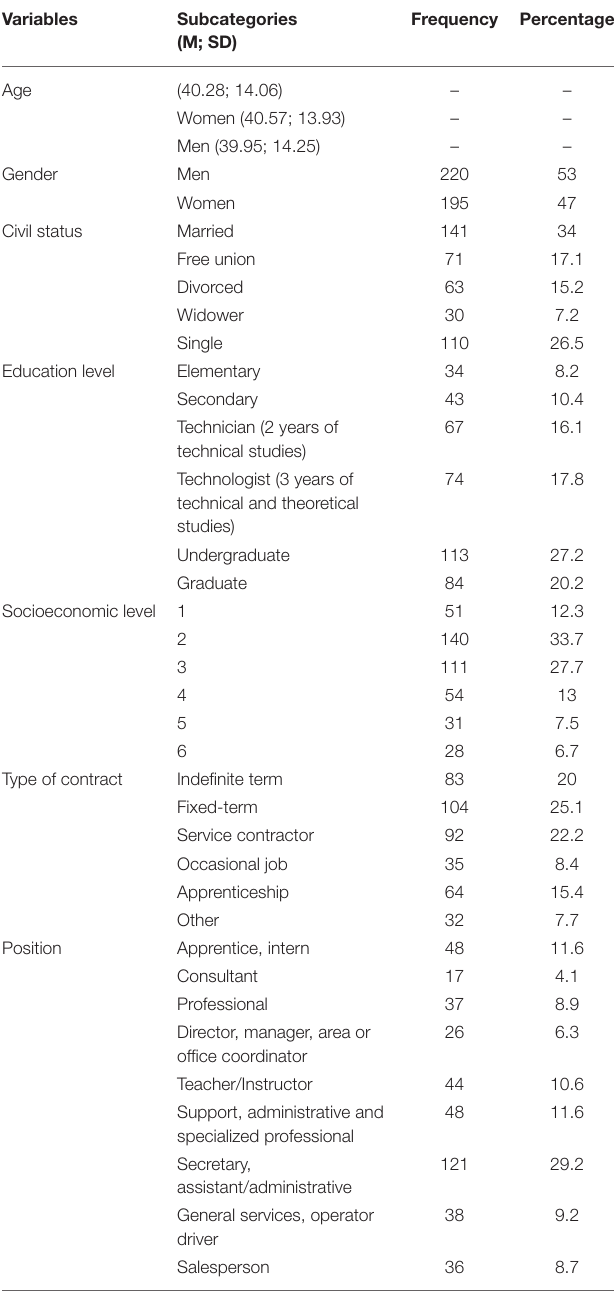
TABLE 1 | Participants’ socio-demographic characteristics ( N =